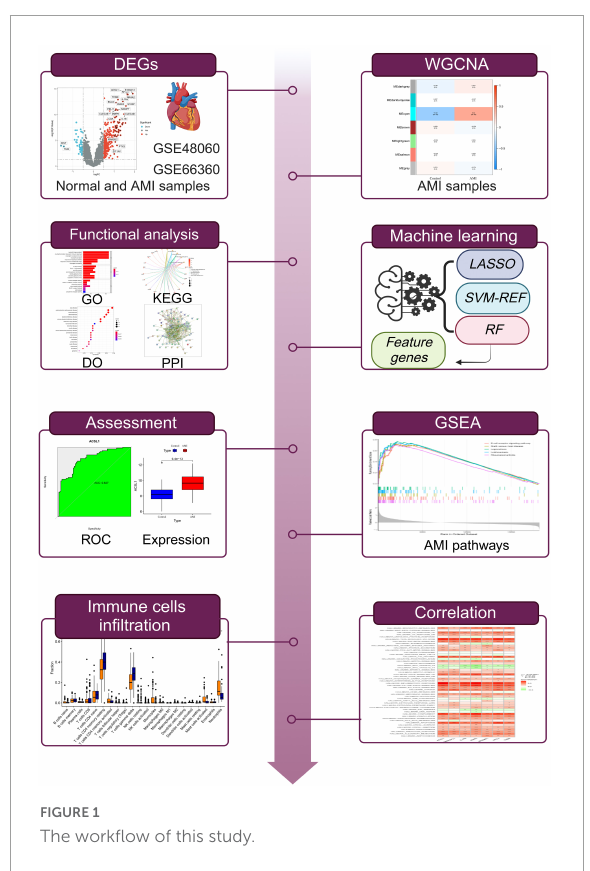
FIGURE1 The workflow of this